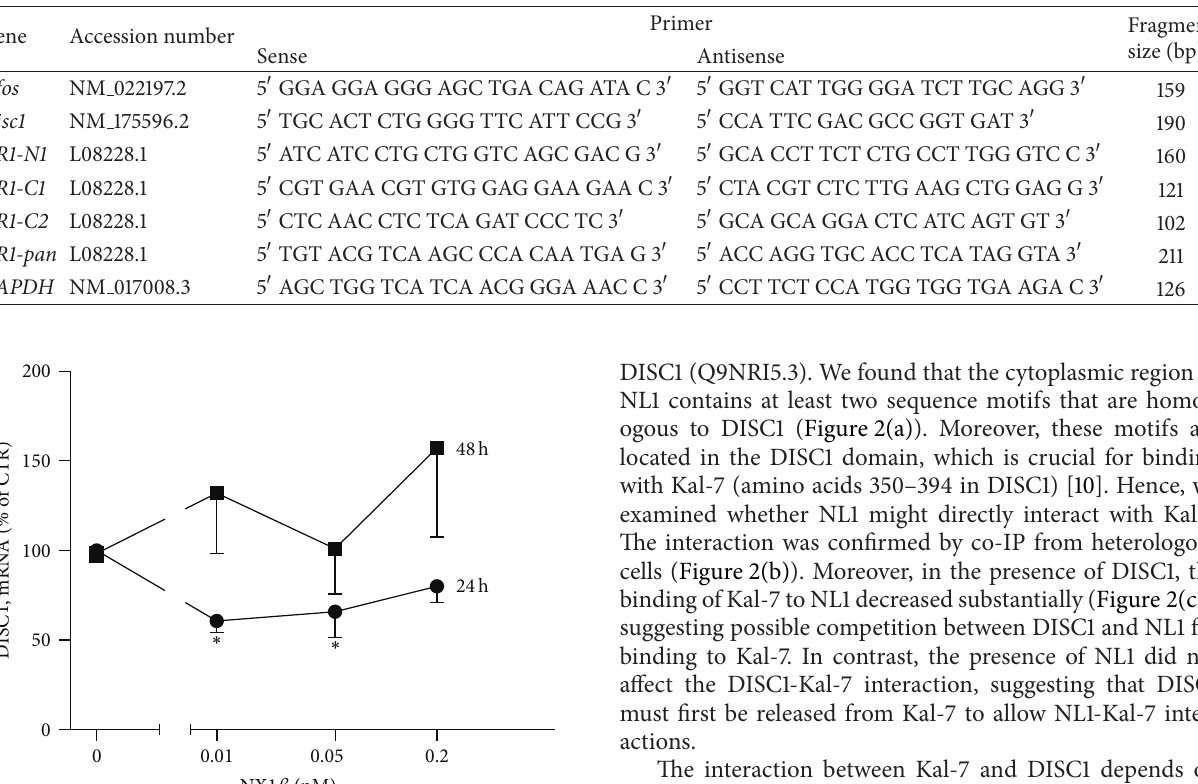
Table 1: List of primers used in the study.